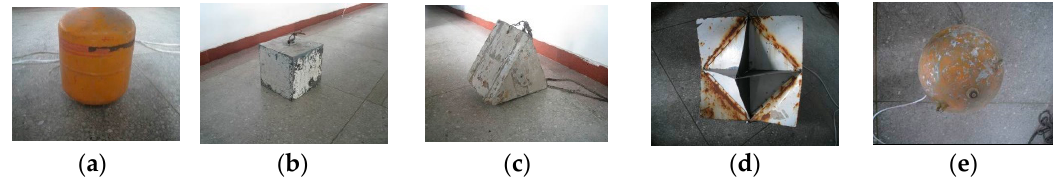
Figure 4. Experiment scene: ( a ) sonar and target launch and ( b ) collected data.